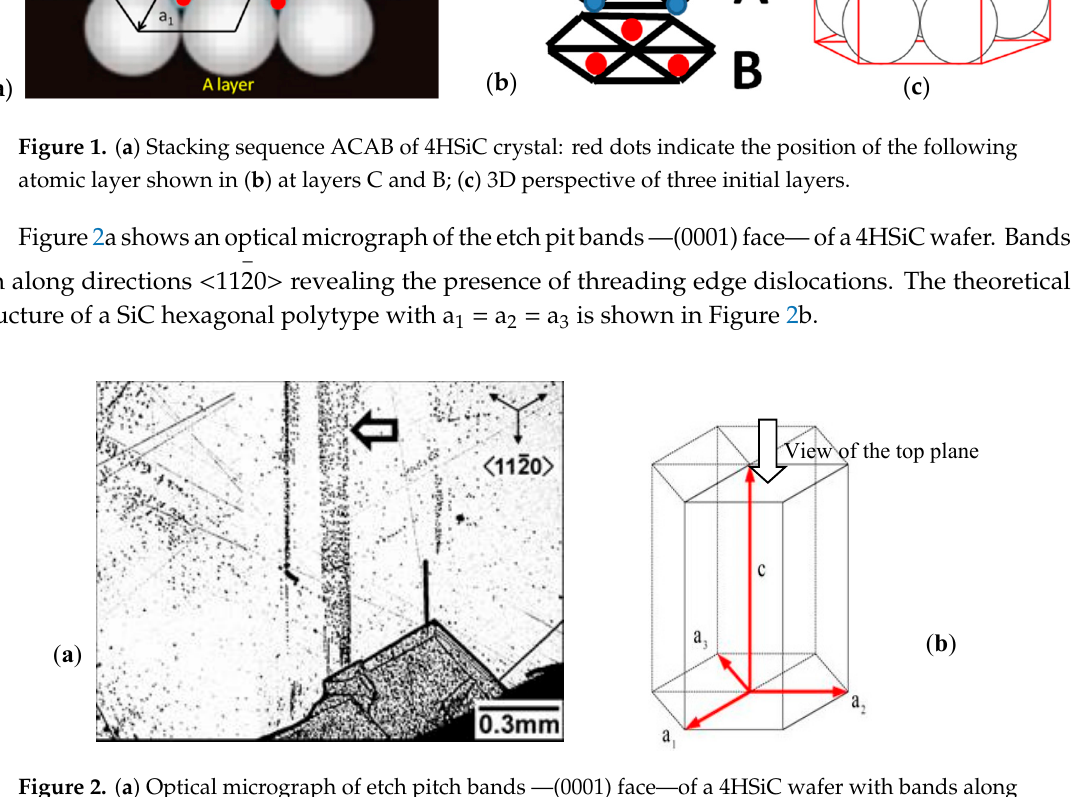
Figure 2. ( a ) Optical micrograph of etch pitch bands —(0001) face—of a 4HSiC wafer with bands along − directions < 11 20 > ; ( b ) theoretical structure of SiC hexagonal polytype with a 1 = a 2 = a 3